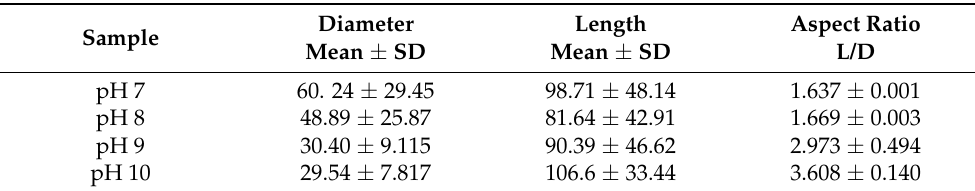
Table 2. Length/diameter (L/D) and aspect ratio of the HAp synthesized by the microwave-assisted method varying the pH.